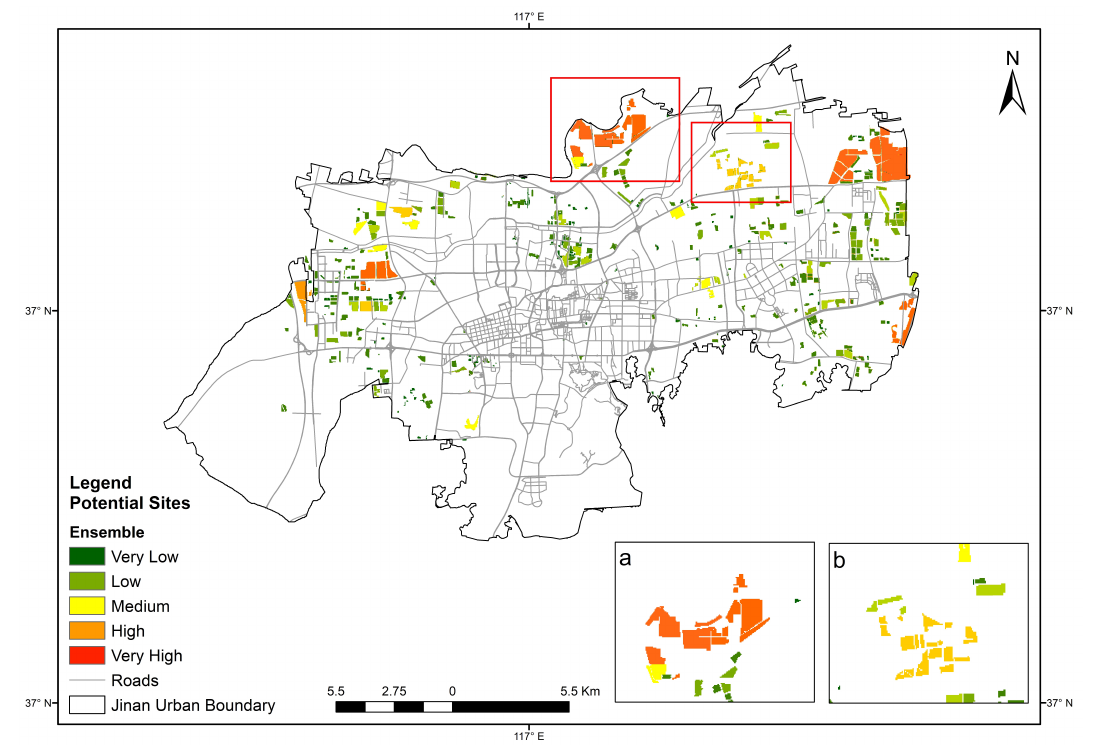
Figure 11. GI development potential sites mapping by stacking model: (bottom right) ( a ) ( b ) North of Jinan likely to be converted into GI.